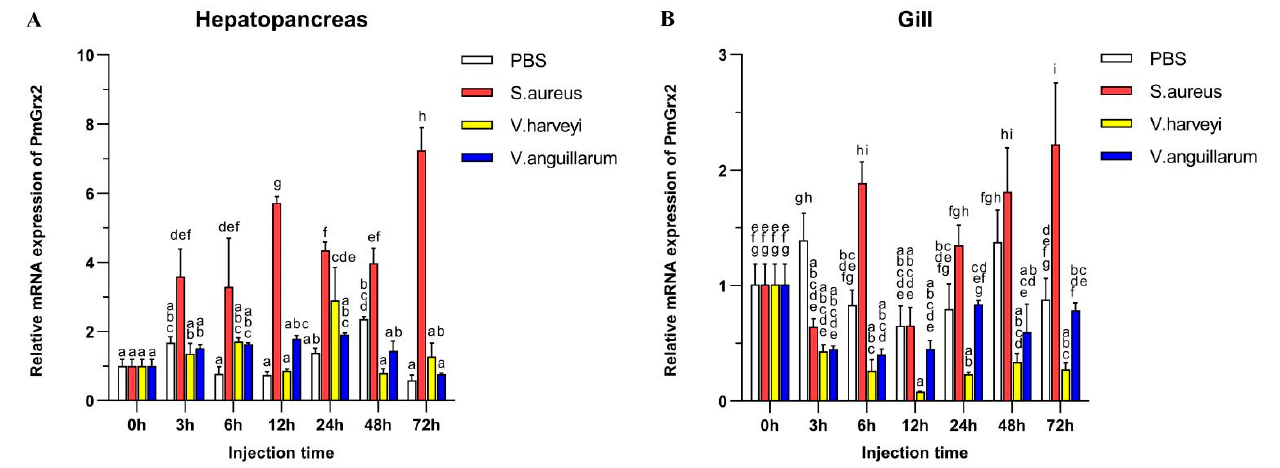
Figure 3. mRNA expression levels of PmGrx2 in the hepatopancreas ( A ) and gill ( B ) at different time intervals after multiple pathogenic bacteria injections. The data are presented as mean ± SD (n = 3). Different letters are used to show significant differences ( p < 0.05).